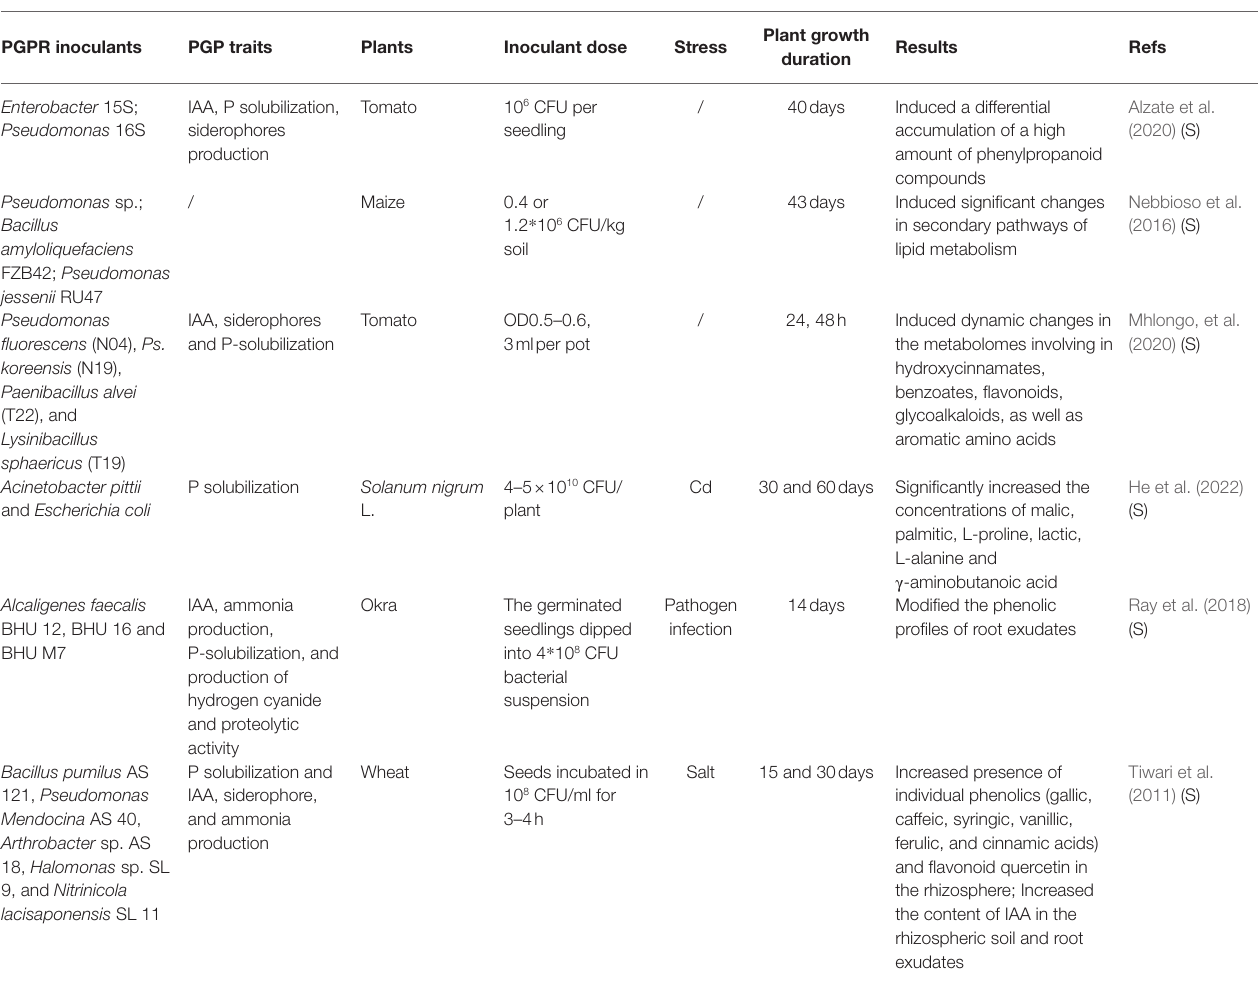
TABLE 2 | The effects of PGPR inoculants on root